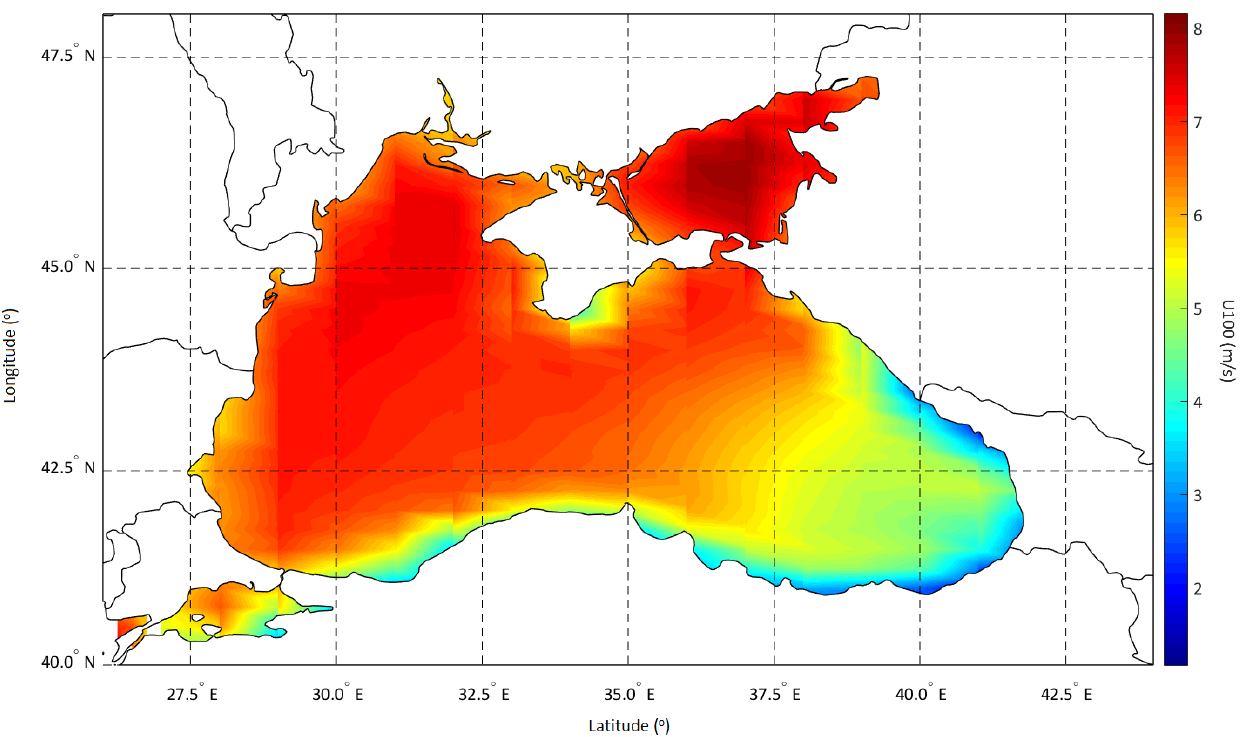
Figure 2. U100 — average wind speed computed for the Black Sea area over the 20-year time interval 2002 – 2021 (full-time distribution). 2002–2021 (full-time